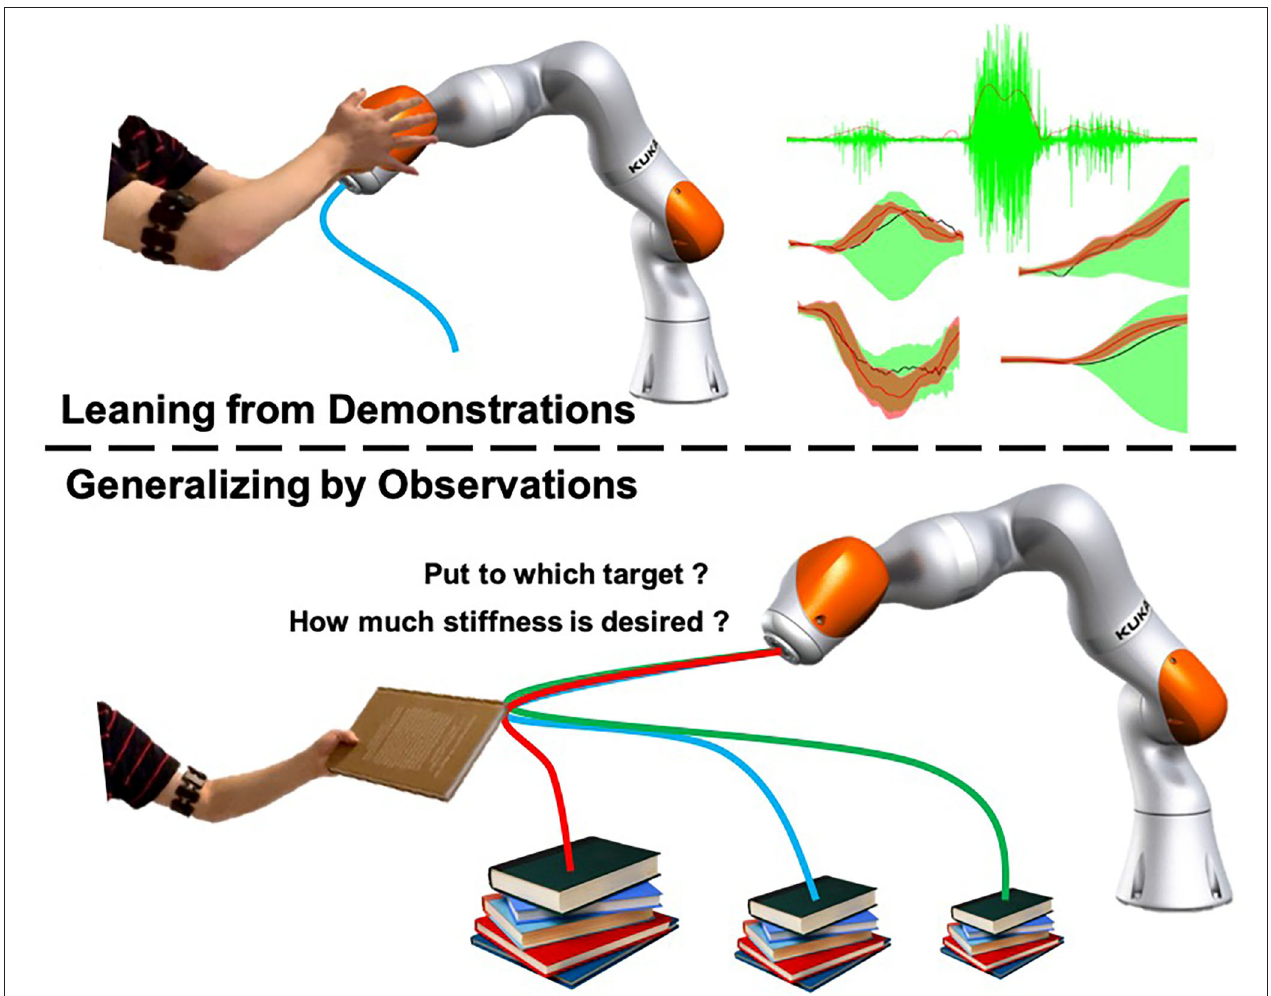
FIGURE 1 | An illustrative figure of the proposed framework. People demonstrate motion and stiffness adaptation skills for both human and robot and encode the collaborative skill using a high-dimensional Probabilistic Movement Primitives (ProMPs) model. The robot will be able to generates appropriate motion and stiffness by observing incomplete data from